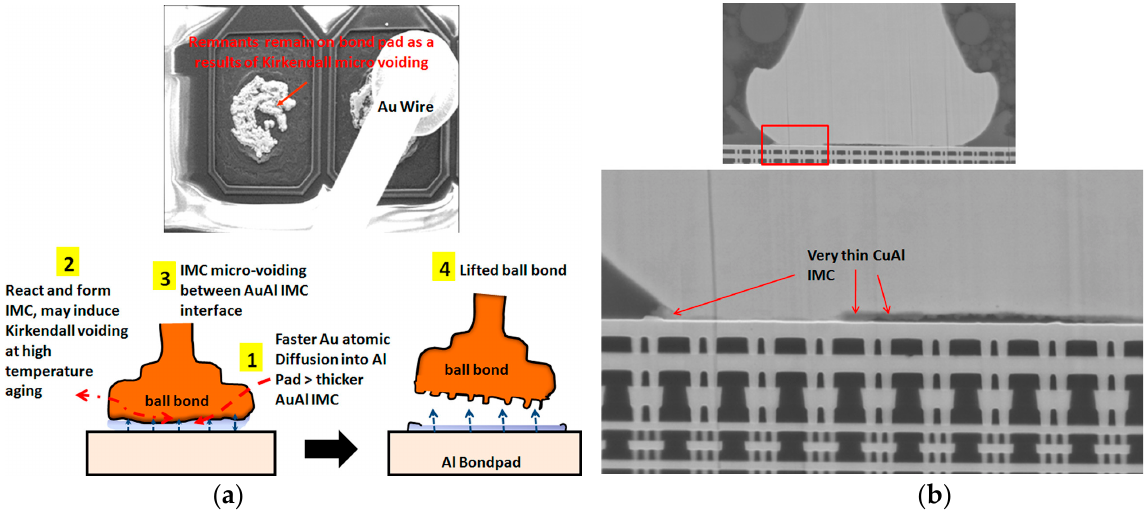
Figure 7. ( a ) Proposed failure mechanism of AuAl Kirkendall micro-voiding and caused lifted ball bond ( b ) SEM images show very thin CuAl IMC formation on bonded stage of Cu wirebond package prior to reliability stress. No microcracking beneath PdCu ball bond. [103]. Copyright, 2013, ASME Digital Collection.